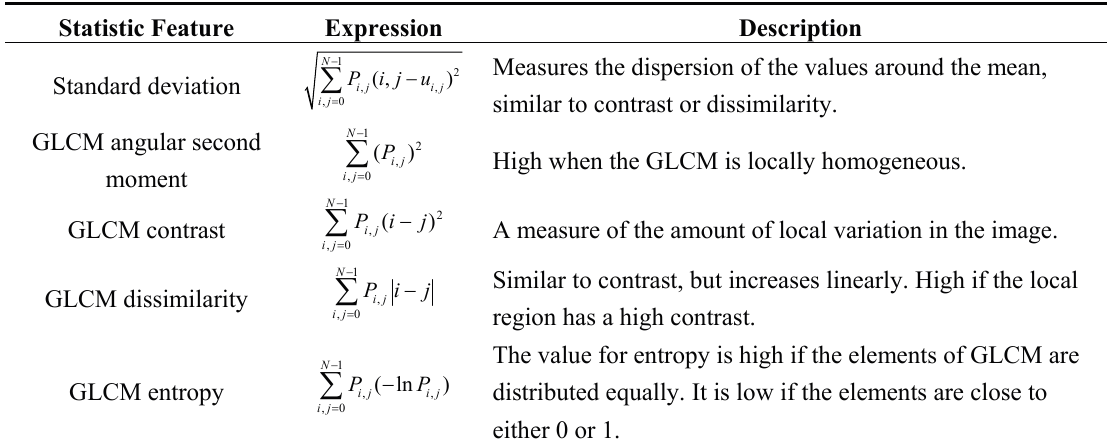
Table 2. Second-order textural measures of LiDAR-derived CHM image objects, calculated using